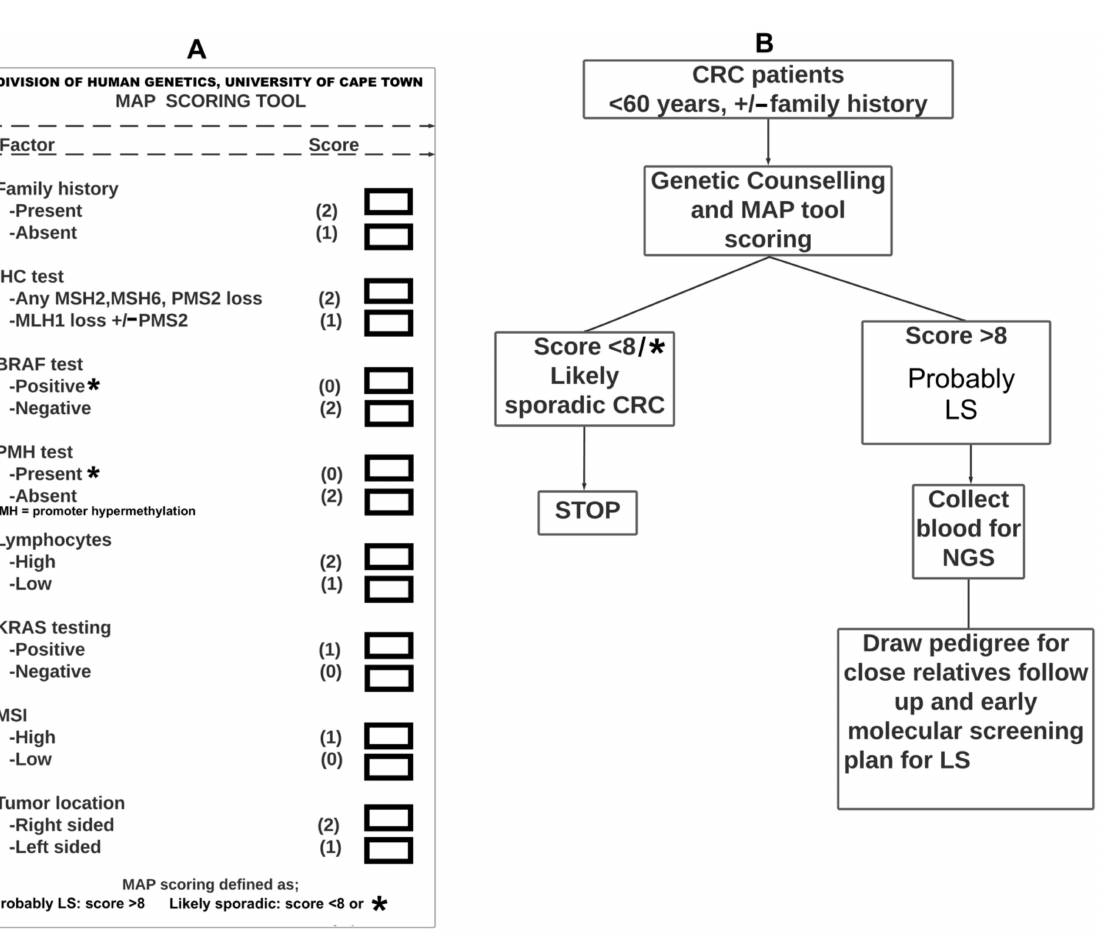
Figure 2. The proposed MAP for screening of CRC patients for PV for LS by NGS. ( A ) The MAP scoring tool/model assigns scores of 0, 1, or 2 to known factors used to diagnose LS. If the